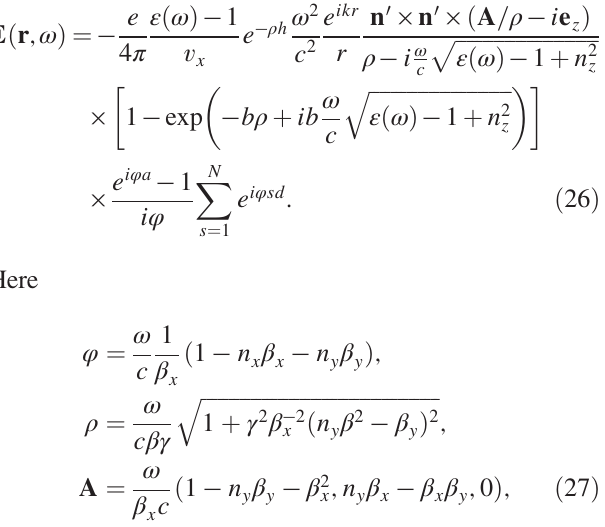
ffiffiffiffiffiffiffiffiffiffiffiffiffiffiffiffiffiffiffiffiffiffiffiffiffiffiffi p ε ð ω Þ − 1 þ n 2 ffiffiffiffiffiffiffiffiffiffiffiffiffiffiffiffiffiffiffiffiffiffiffiffiffiffiffi